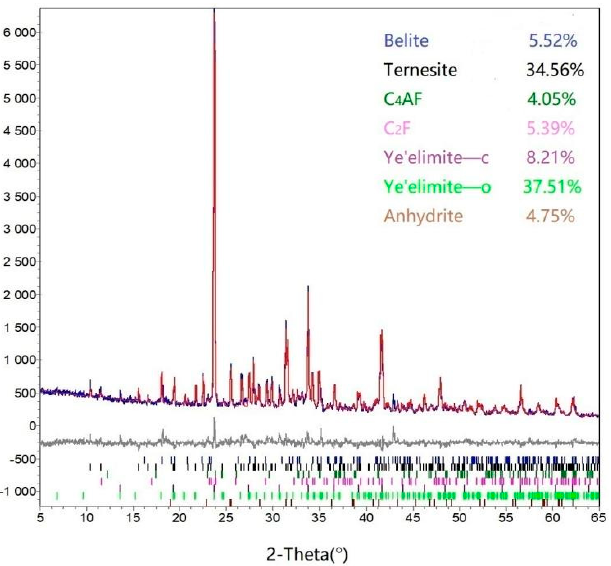
Figure 8. Rietveld refinements for the TCSA cement clinker with 0.3% Na 2 O, R wp =